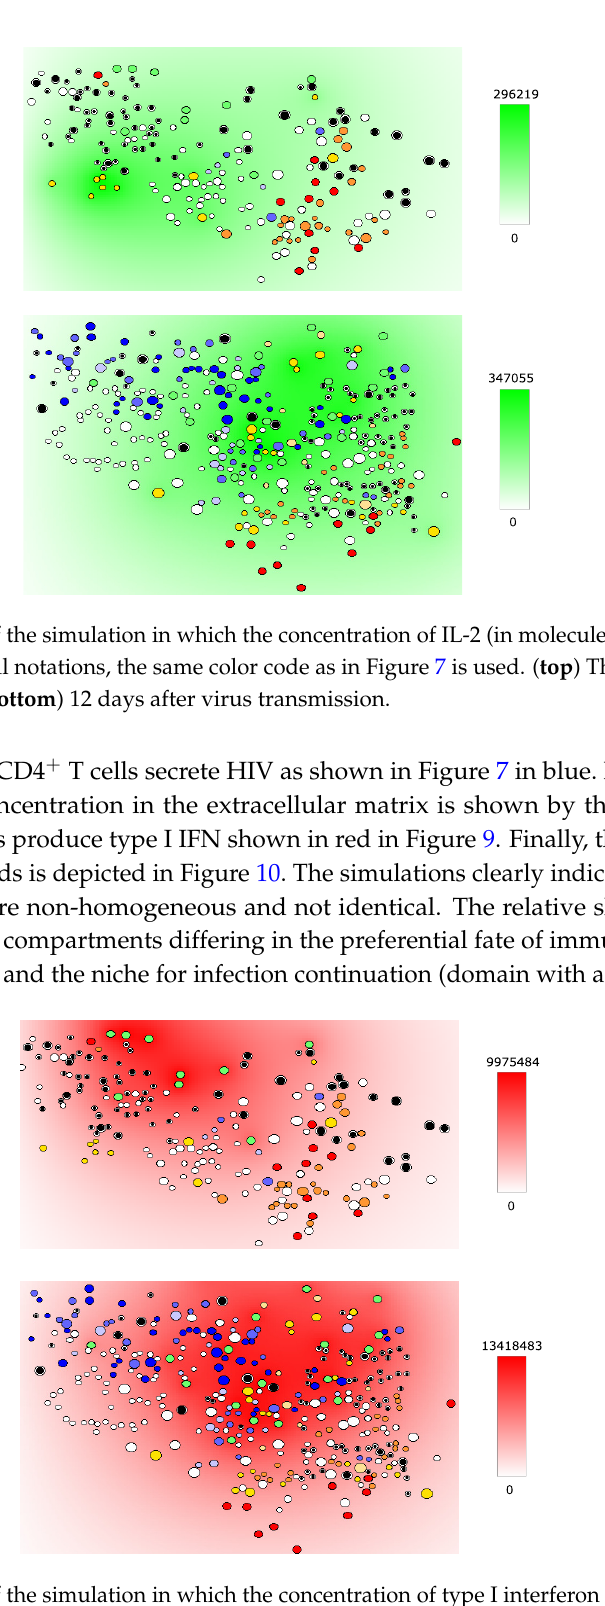
Figure 9. Snapshots of the simulation in which the concentration of type I interferon (in molecules/ µ L) is shown in red color gradient. For cell notations, the same color code as in Figure 7 is used. ( top ) Three days after the virus transmission; ( bottom ) 12 days after virus